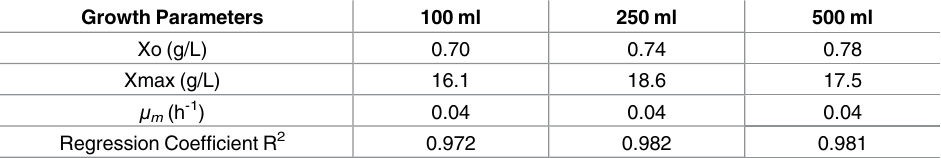
Table 2. Parameters defining the logistic model of fungal growth. L . theobromae strain 2334 was culti- vated in shake flasks of 100 mL, 250 mL and 500 mL in the presenceof KNO 3 as nitrogensource. Growth Parameters